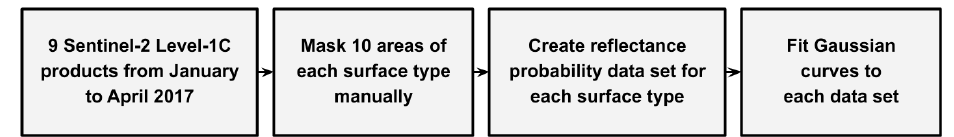
Figure 2. Data analysis steps for obtaining the Gaussian curves for each surface type.